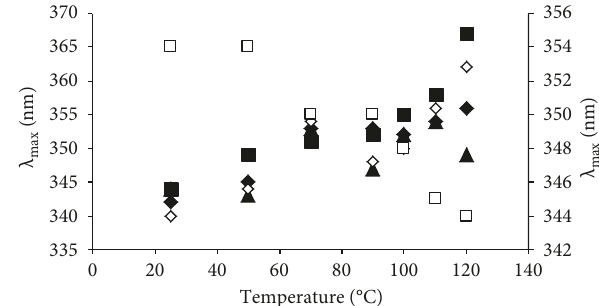
Figure 5: Correlations between TAC after prolonged heating of 64.89 kJ/mol for anthocyanins degradation at the tem- perature range from 70 to 90 ° C in grape juice. Hillmann [33]